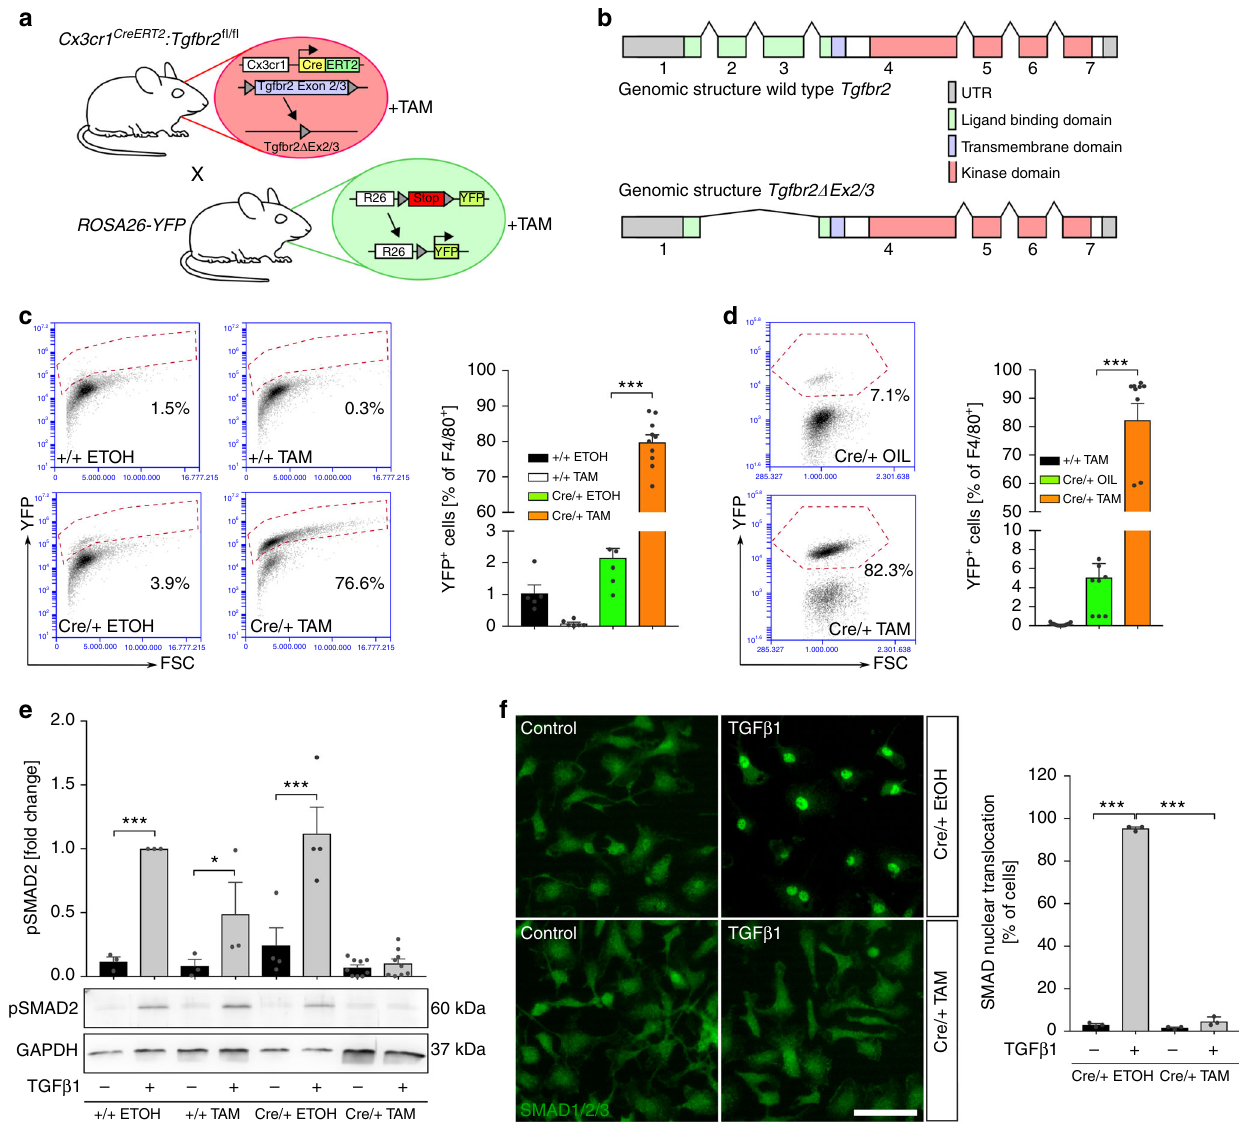
Fig. 1 Successful microglia-speci fi c knockout of Tgfbr2 in vitro and in vivo. a Scheme illustrating breeding strategy to obtain Cx3cr1 CreERT2 :R26-yfp,Tgfbr2 fl / fl mice for TAM-induced deletion of Tgfbr2 Exons 2/3 and induction of YFP reporter gene expression. b Genomic structure of wild-type and mutant Tgfbr2 after TAM-induced recombination. c Flow cytometric analysis of microglia 3 days after TAM-induced recombination in vitro for expression of YFP. Data are presented as mean ± SEM ( + / + EtOH n = 5, + / + TAM n = 6, Cre/ + EtOH n = 7, Cre/ + TAM n = 10). P values derived from one-way ANOVA are *** p < 0.001. d Flow cytometric analysis of YFP reporter gene expression 4 weeks after recombination in vivo. Data are given as means ± SEM ( + / + TAM n = 12, Cre/ + OIL n = 8, Cre/ + TAM n = 10). P values derived from one-way ANOVA are *** p < 0.001. e Primary microglia from newborn Cx3cr1 CreERT2 :R26-yfp, Tgfbr2 fl / fl were recombined in vitro. Control ( + / + EtOH, + / + TAM, Cre/ + EtOH) and knockout (Cre/ + TAM) samples were treated with TGF β 1 (5 ng/ ml) for 2 h. Quanti fi cation of SMAD2 phosphorylation (pSMAD2) after densitometric evaluation and GAPDH normalisation ( + / + EtOH n = 3, + / + TAM n = 3, Cre/ + EtOH n = 4, Cre/ + TAM n = 9). Data are given as fold changes compared to + / + EtOH-treated samples. P values derived from one-sample t tests are * p < 0.05 and *** p < 0.001. f Nuclear translocation of SMAD2 was determined in primary microglia after treatment with TGF β 1 (5 ng/ μ l) for 2 h. Scale bar represents 50 µ m. Data are given as means ± SEM from three independent experiments. P values derived from one-way ANOVA are *** p <